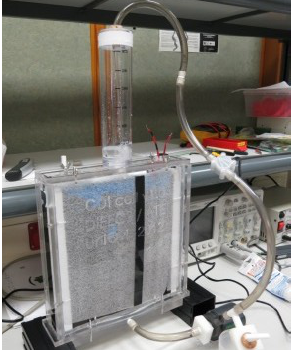
Figure 5. Capacitive De-Ionization (CDI) module prototype.